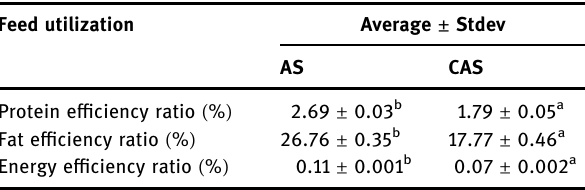
Table 3: Feed utilization e ffi ciency of fi sh reared for 30 days in the di ff erent aquaculture systems